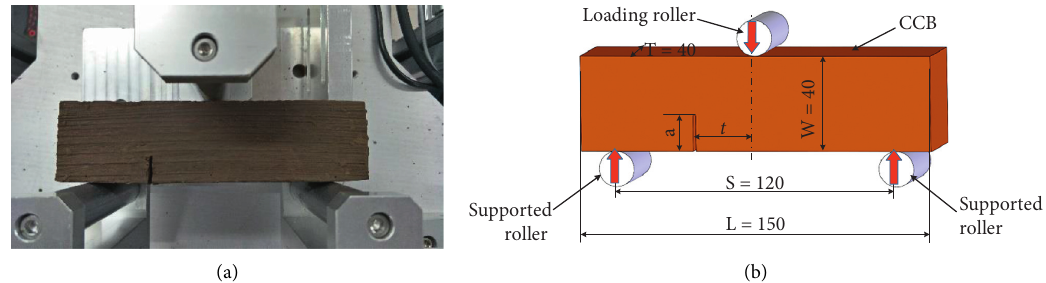
Figure 1: The CCB specimen with offset notch used for TPB test. (a) Experimental setup; (b) the schematic diagram of TPB test.